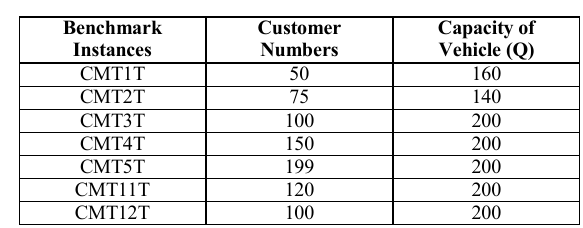
TABLE III. P ARAMETERS OF CMT